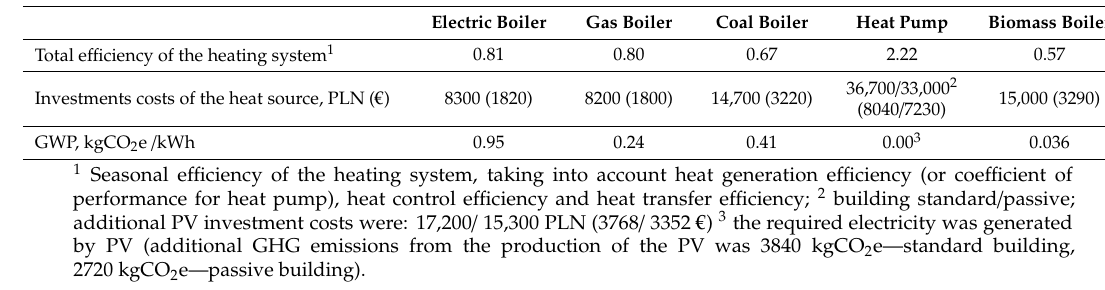
Table 3. Data for the heat sources.